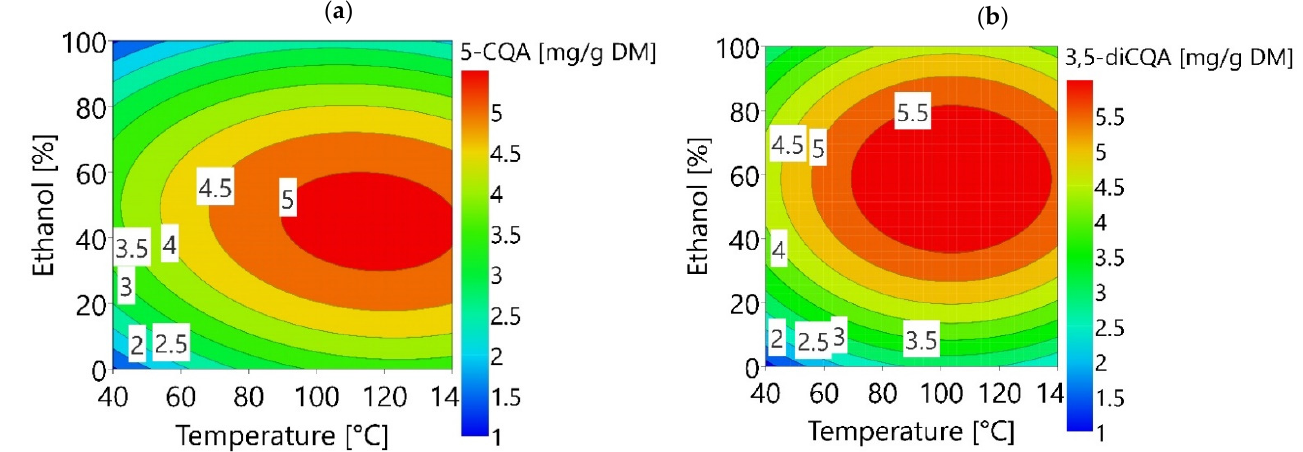
Figure 3. ( a ) Response surface plot of Y 5-CQA ; ( b ) Y 3,5-diCQA .